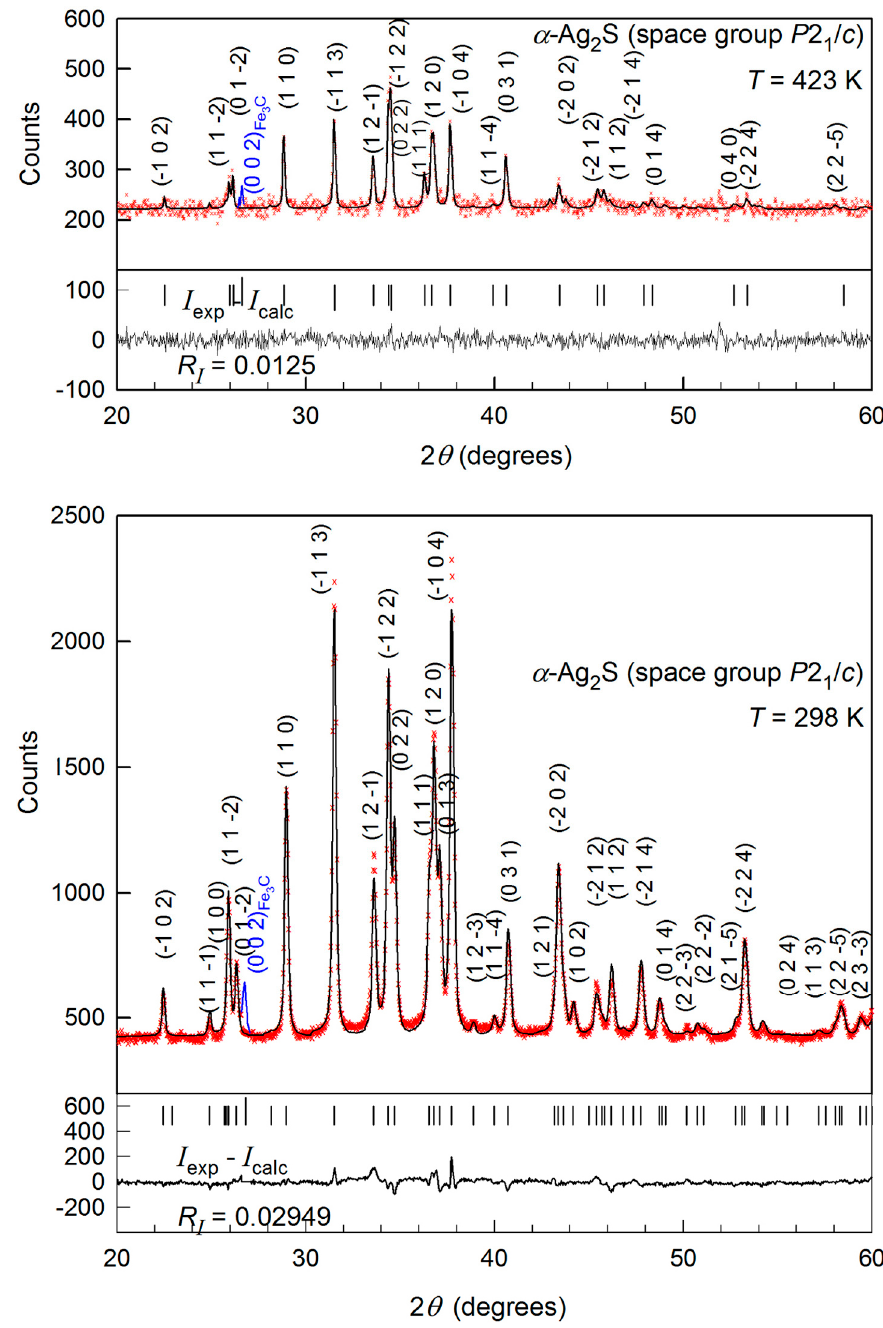
Figure 1. Experimental ( × ), calculated (—), and difference ( I exp — I calc ) XRD patterns of Ag 2 S pressed pill at temperatures of 298 and 423 K. According to refinement, Ag 2 S at 298 and 423 K is monoclinic (space group P2 1 /c) α -Ag 2 S acanthite.